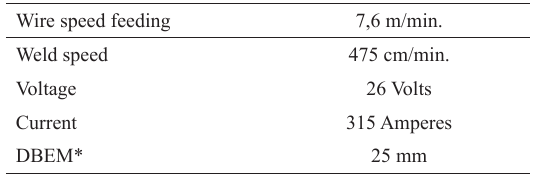
Figure 1: Schematic detail of the procedures “pushing” and “pulling” the torch with electrode inclined at 15 degree. Table 2: Welding